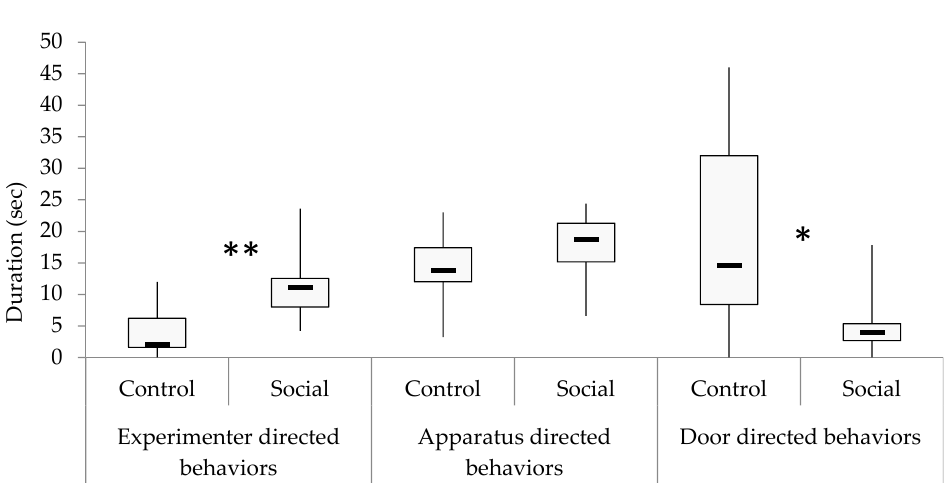
Figure 1. The duration (in seconds) of Experimenter/Apparatus/Door directed behaviors in the control and socialized groups. Black rectangles: medians; boxes: from 25% to 75% quartiles; thin vertical lines: minimum and maximum values. * p < 0.05, ** p < 0.01.